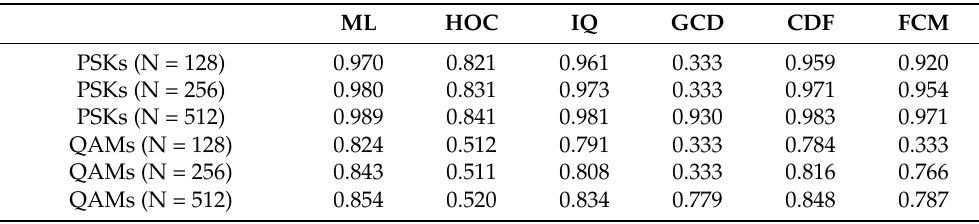
Table 5. Average probability of correct classification of different features under non-Gaussian channel at N = 128, 256, and 512.